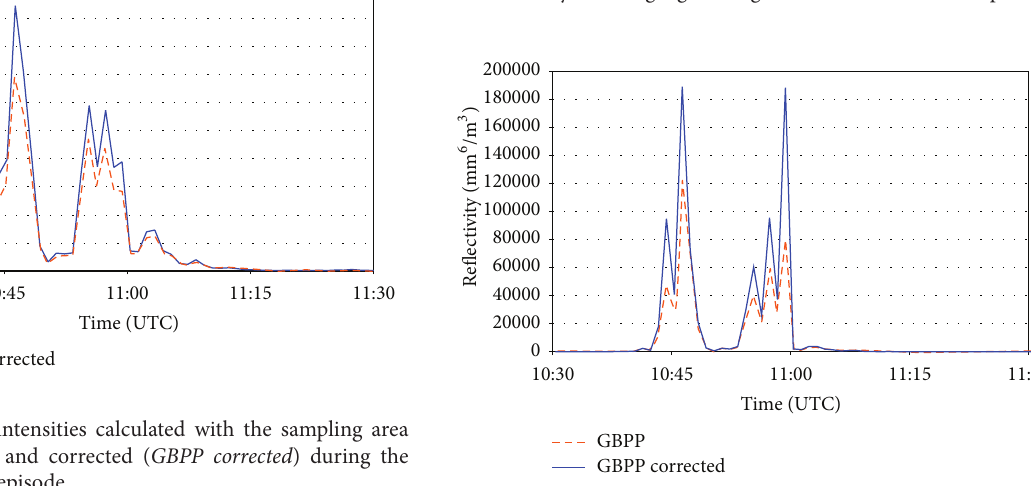
Figure 11: Comparison between the total rainfall recorded by the GBPPandbytheraingaugeduringthemostintenserainfallepisode.